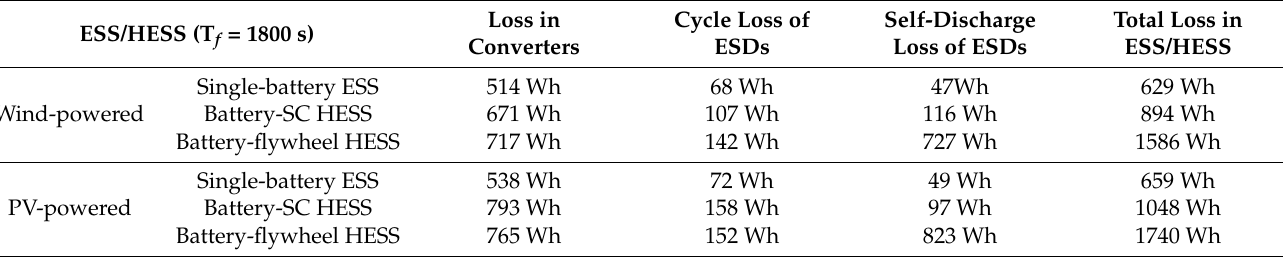
Table 1. Losses in different ESS combinations.